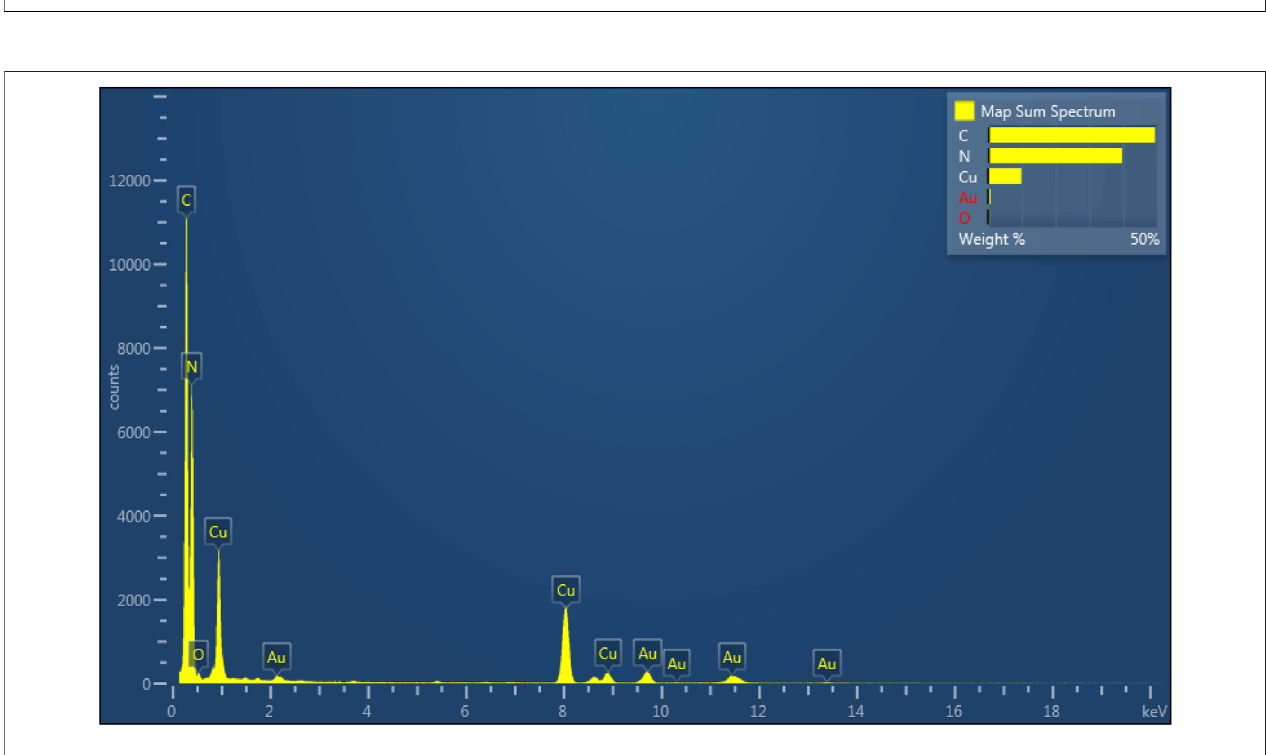
FIGURE 4 | EDS spectrum of 7-%CuO/g-C 3 N 4 .